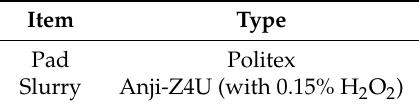
Table 1. Specifications of the pad and slurry.